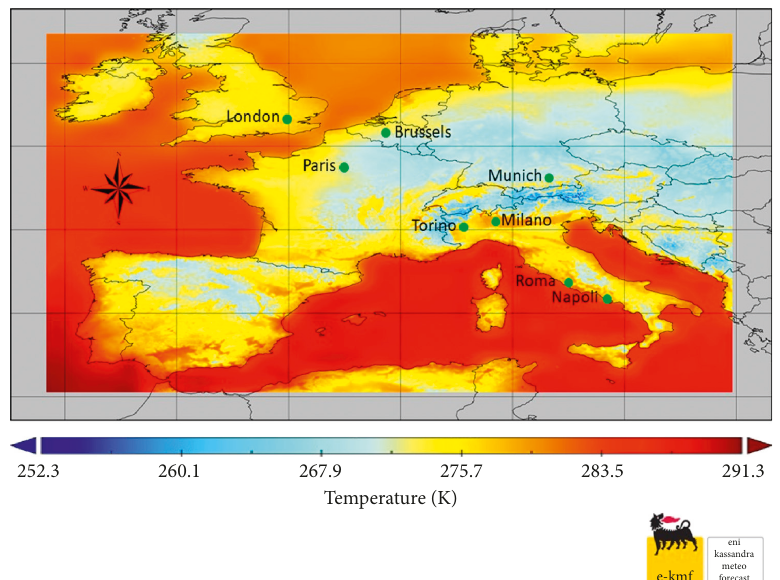
Figure 1: e-kmf ™ European domain with the eight cities, where the analysis for short- and medium-term temperature forecasts has been carried